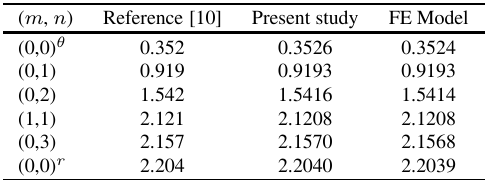
Table 1 Comparisons of frequency parameters Ω of in-plane vibra- tion of an annular disk clamped at the inner edge ( v = 0.3, β = 0.2)